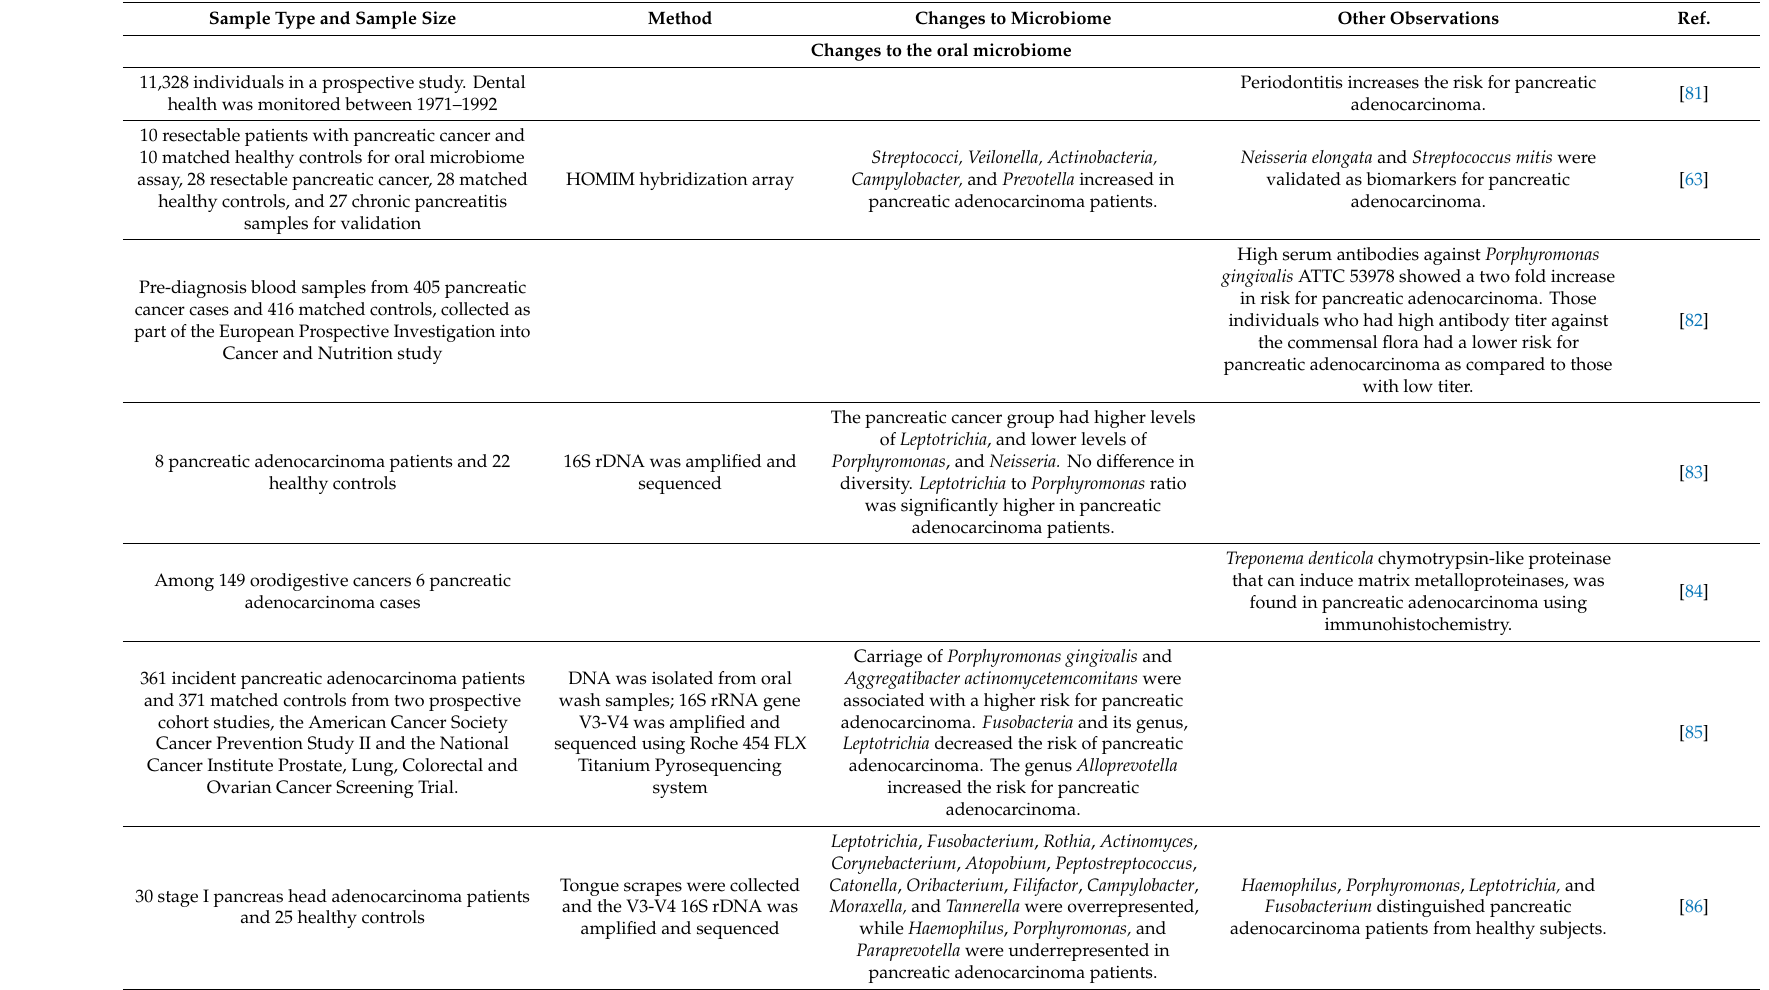
Table 1. The main findings of the human oncobiome studies in pancreatic